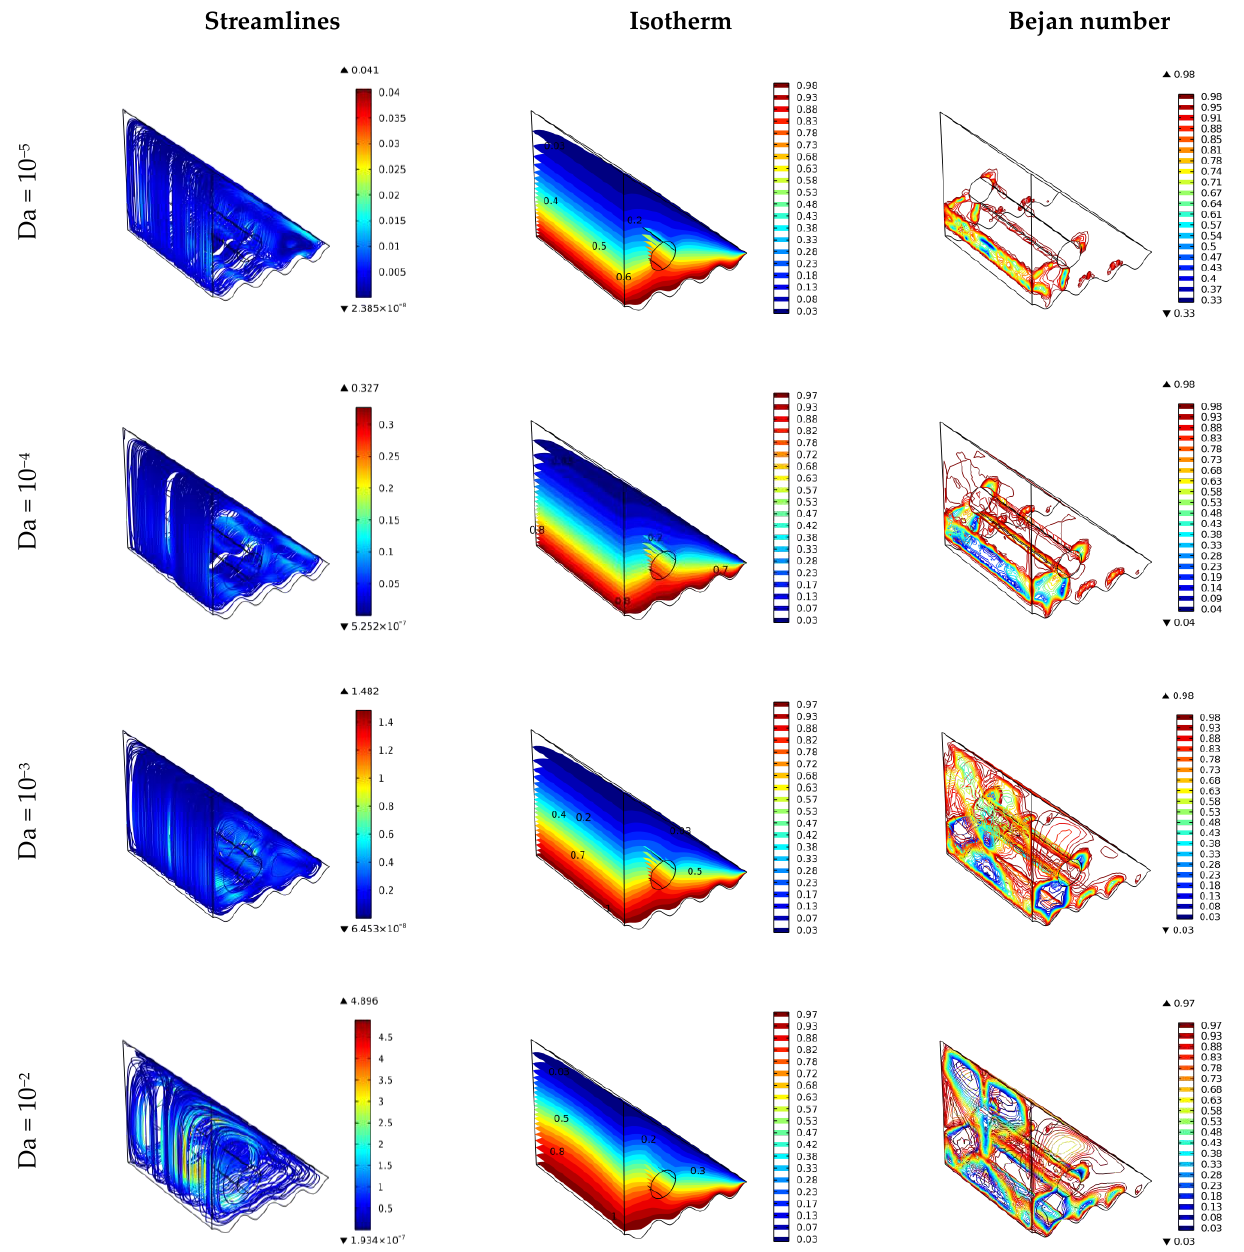
Figure 6. Surface plots of the velocity, temperature, and Bejan number for various Darcy number values.